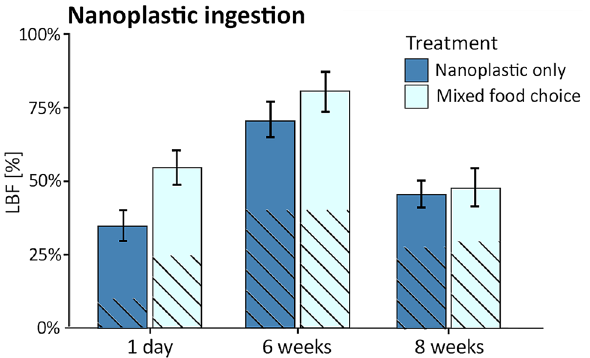
Figure 3. Ingestion occurrences on nanoplastics (% LBF; n = 80 LBF per treatment) observed in the nanoplastic-only treatment and in the mixed treatment. Hatched areas mark percentage of LBF with nanoplastic being located solely in the newest chamber. Ingestion occurrences are shown after 1 day of nanoplastic exposure, after 6 weeks of exposure, and after 8 weeks (6 weeks exposure + 2 weeks recovery). Error bars show standard error of total ingestion